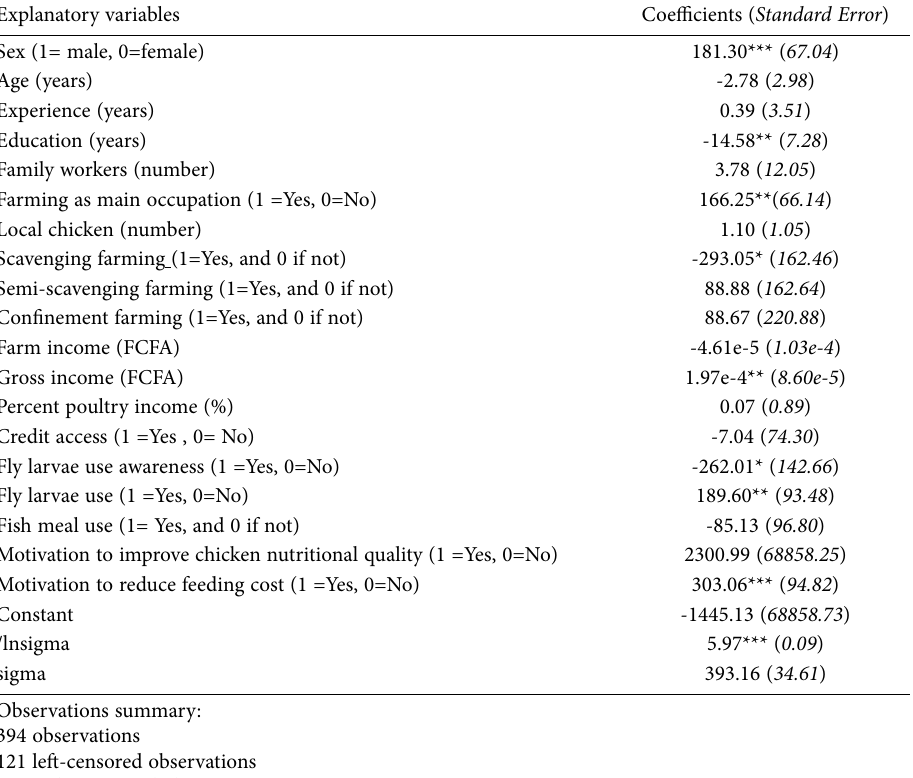
Table 5. Factors affecting respondents’